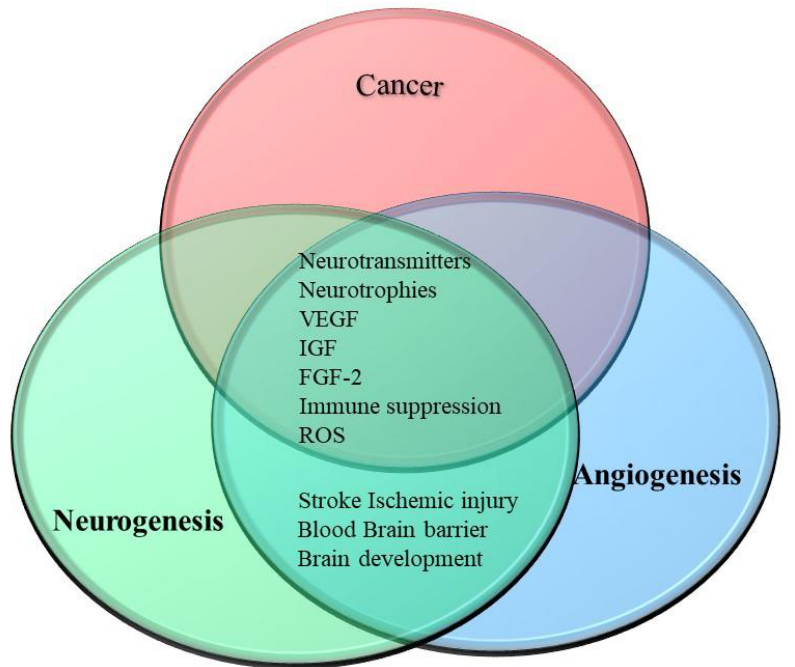
Figure 7. Relationship between neurogenesis and angiogenesis in cancer. The interplay between angiogenesis and neurogenesis is due to signaling molecules, such as neurotrophins,